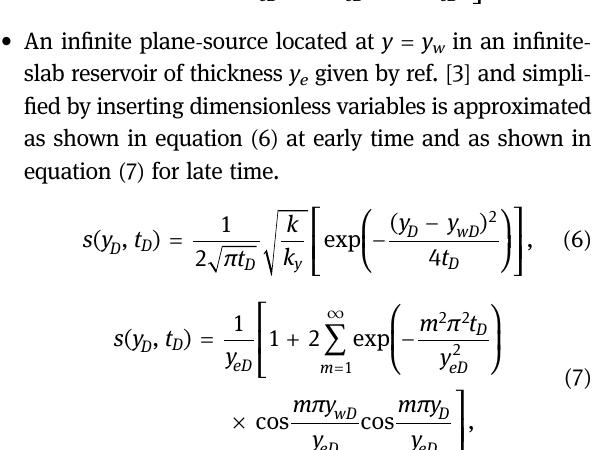
fi nite - w in an in